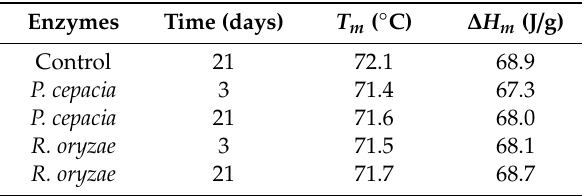
Figure 4. DSC heating scans (10 °C/min) corresponding to the initial suture (purple line), the suture exposed to a Rhizopus oryzae medium at 37 °C for the indicated days (black lines), the suture exposed to a Pseudomonas cepacia medium at 37 °C for 21 days (blue line), and the control (green line) (pH 7.4 medium for 21 days and 37 °C). Table 2. Melting peak temperatures and enthalpies of P4HB sutures exposed at 37 °C to the indicated enzymatic degradation medium and exposure time.